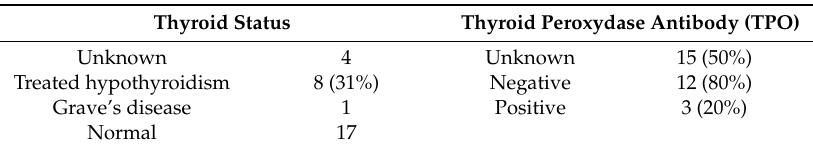
Table 3. Thyroid status at the time of